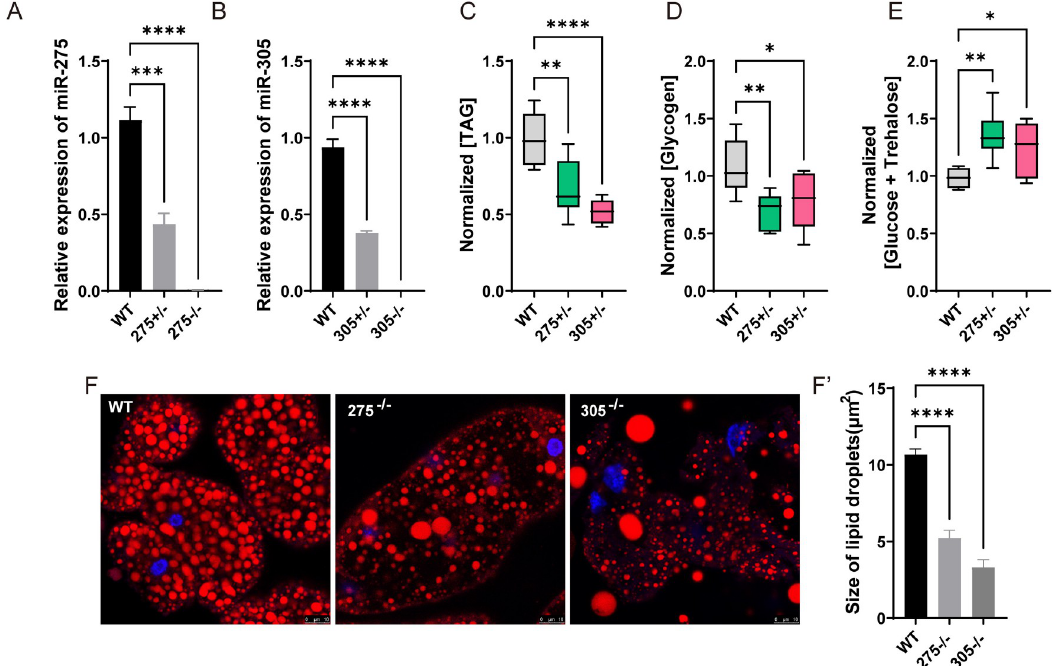
Fig 3. Targeted mutation of miR-275 and miR-305 impaired physiological metabolism. (A-B) Relative expression levels of mature miR-275 (A) and miR-305 (B) in homozygote (-/-), heterozygote (+/-), and wild-type flies. (C-E) Effects of miRNA mutation on energy substrate metabolism in heterozygote. (C) TAG content. (D) glycogen content. (E) total sugar content (glucose plus trehalose). Data were normalized to total protein content. Data represent seven to ten biological replicates with three technical replicates. � , P < 0.05; �� , P < 0.01; ��� , P < 0.001, and ���� , P < 0.0001 (Student’s t-test). (F-F’) Nile Red staining of lipid droplets. The fat body was obtained from miR-275 -/- , miR-305 -/- , and wild-type females at 5 DPE. Red, Nile Red staining for neutral lipids; and blue, DAPI staining for nuclei. Lipid droplets were visualized and imaged with a Leica SP8 confocal microscope (Scale bar: 10 μ m.), and the size was quantified using ImageJ.